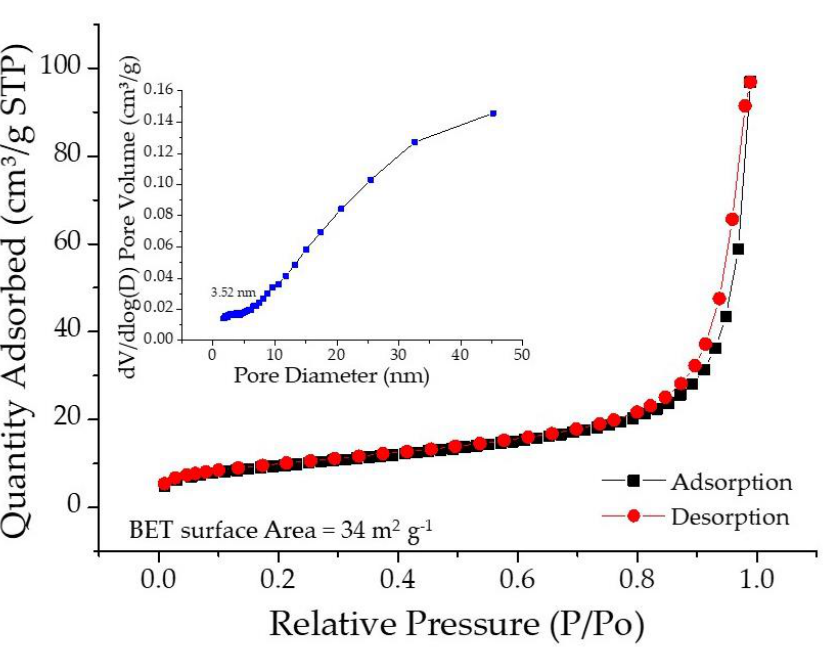
Figure 3. Nitrogen adsorption – desorption curves with the corresponding pore size distribution plots for the composite material SPani-AC.